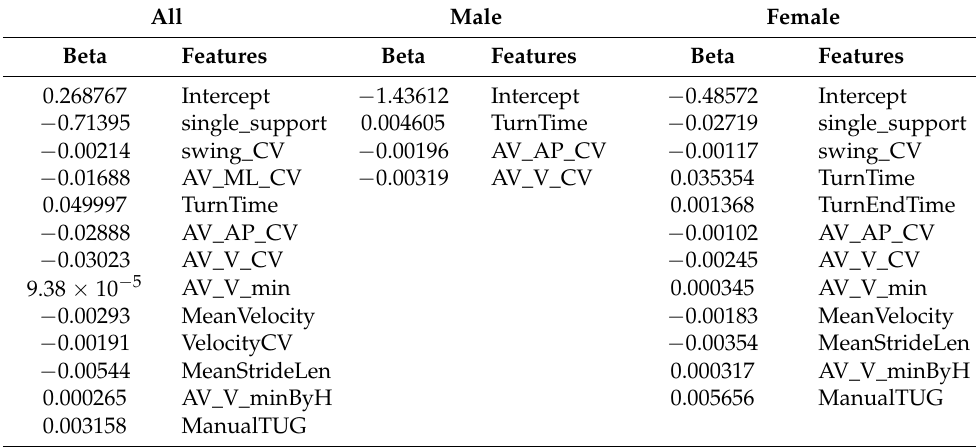
Table A7. TD-Fallers falls count model coefficients. Beta refers to Poisson regression coefficients, chosen through an elastic net procedure.